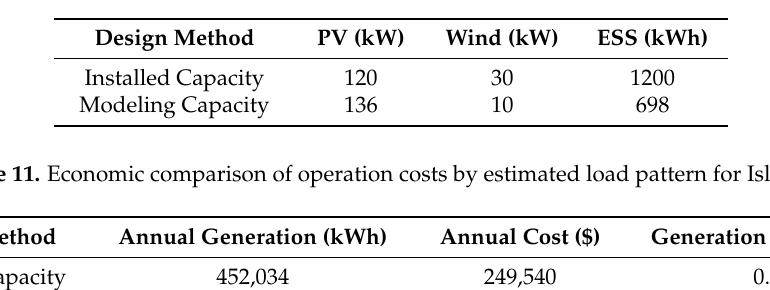
Table 10. Installed capacity and modeled one by estimated load pattern for Island 7.